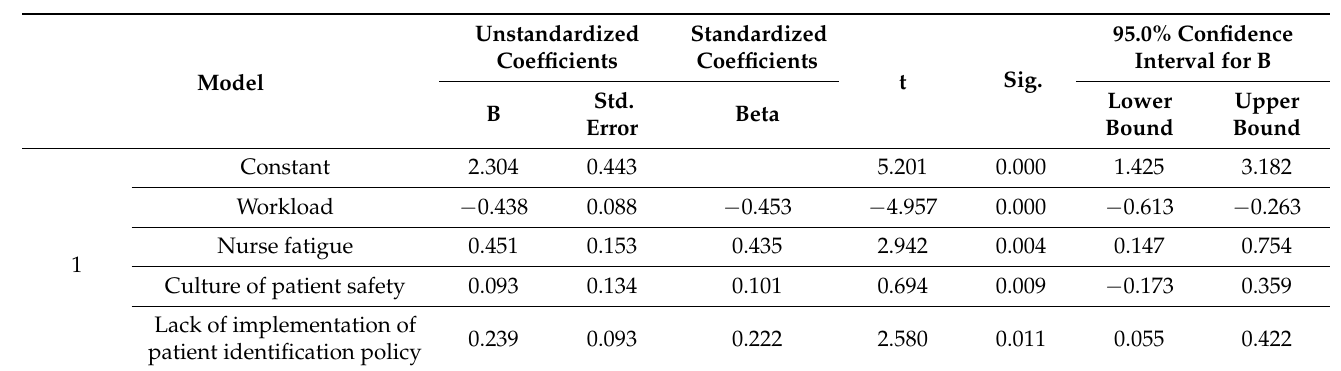
Table 10. Coefficients.